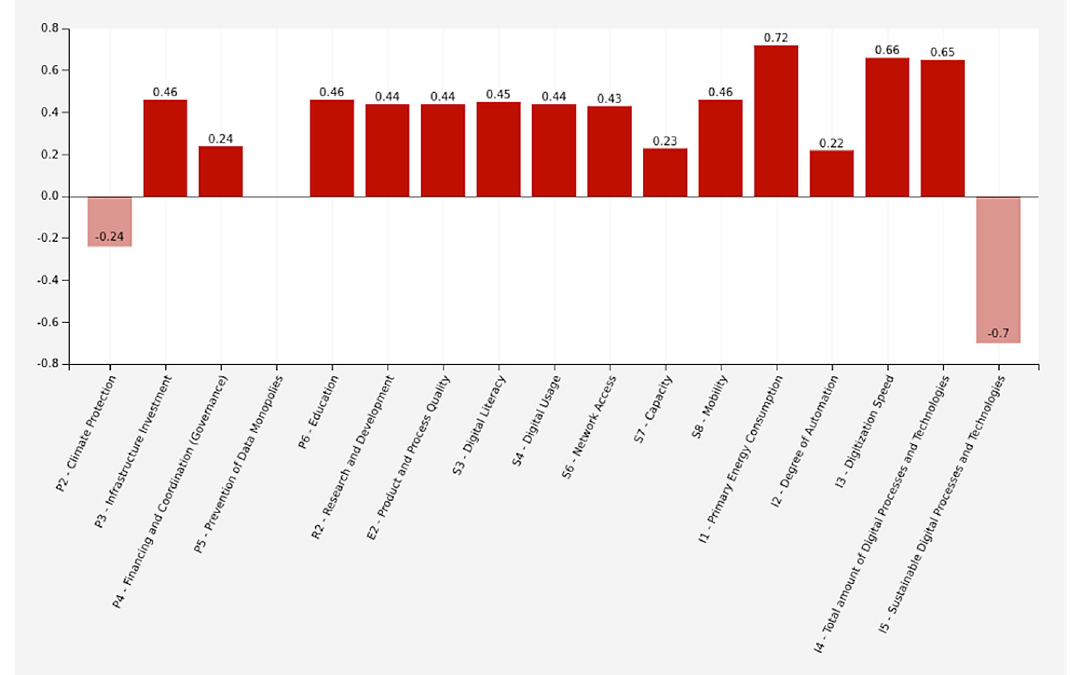
Figure 4. Simulation results. Traditional growth-oriented scenario (Screenshot from Mental Modeler